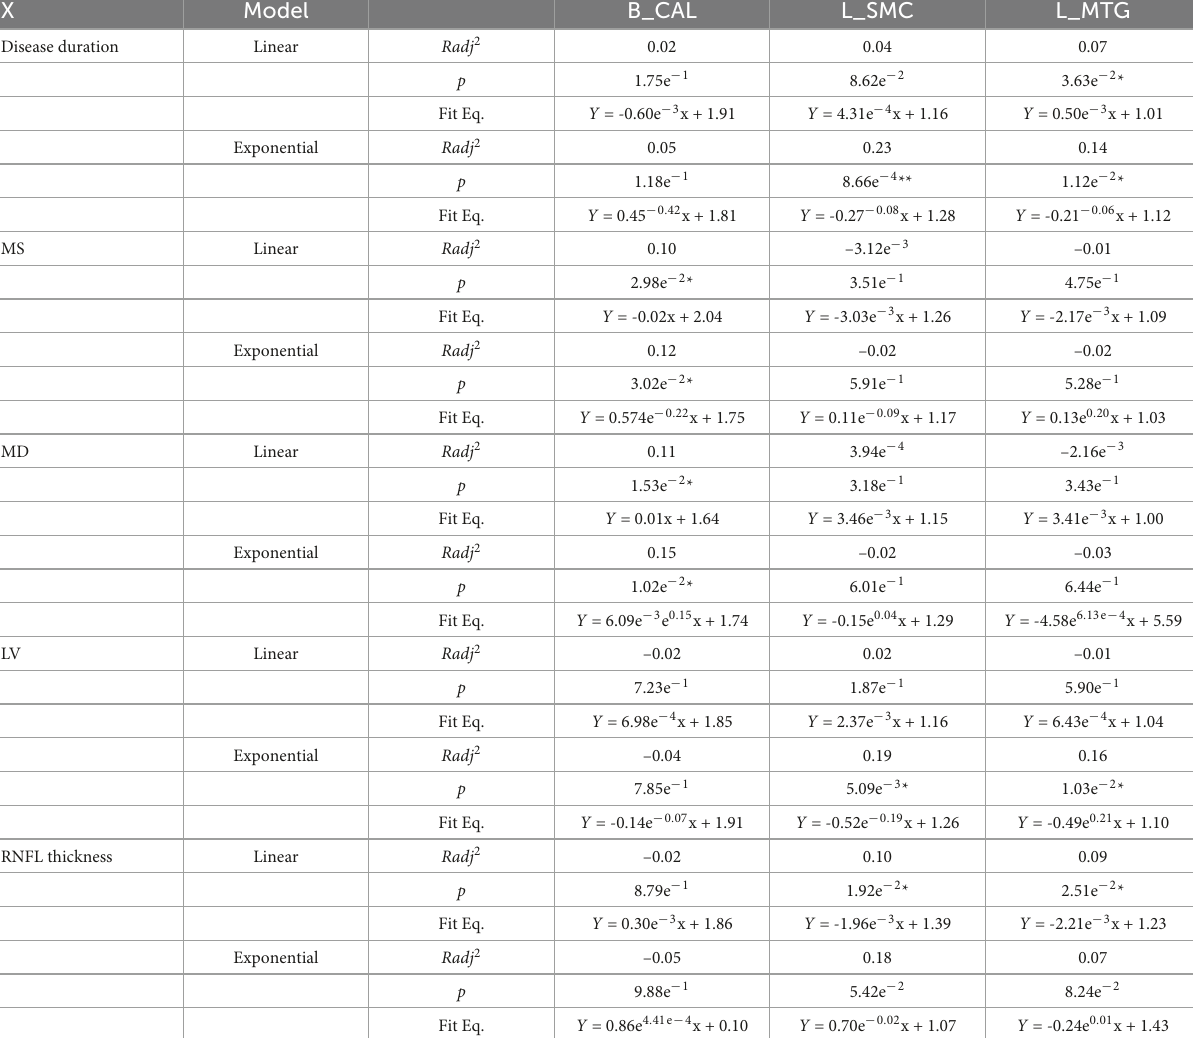
TABLE 4 Correlation between ReHo/CBF ratio and clinical measures.